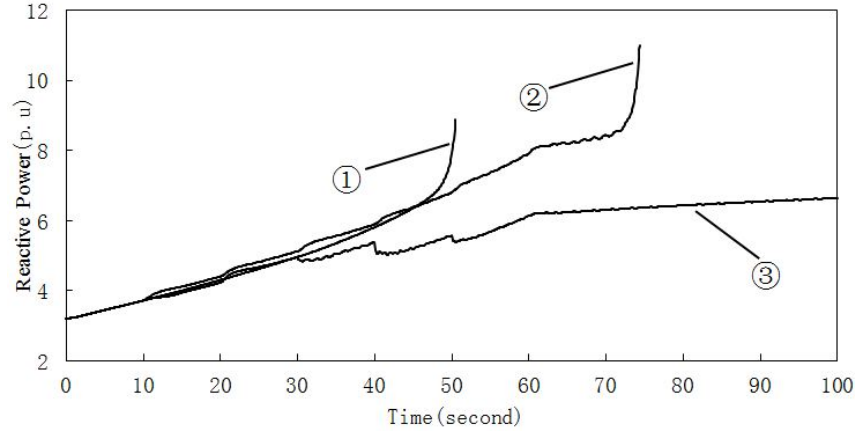
Figure 8. Reactive power curve of generator